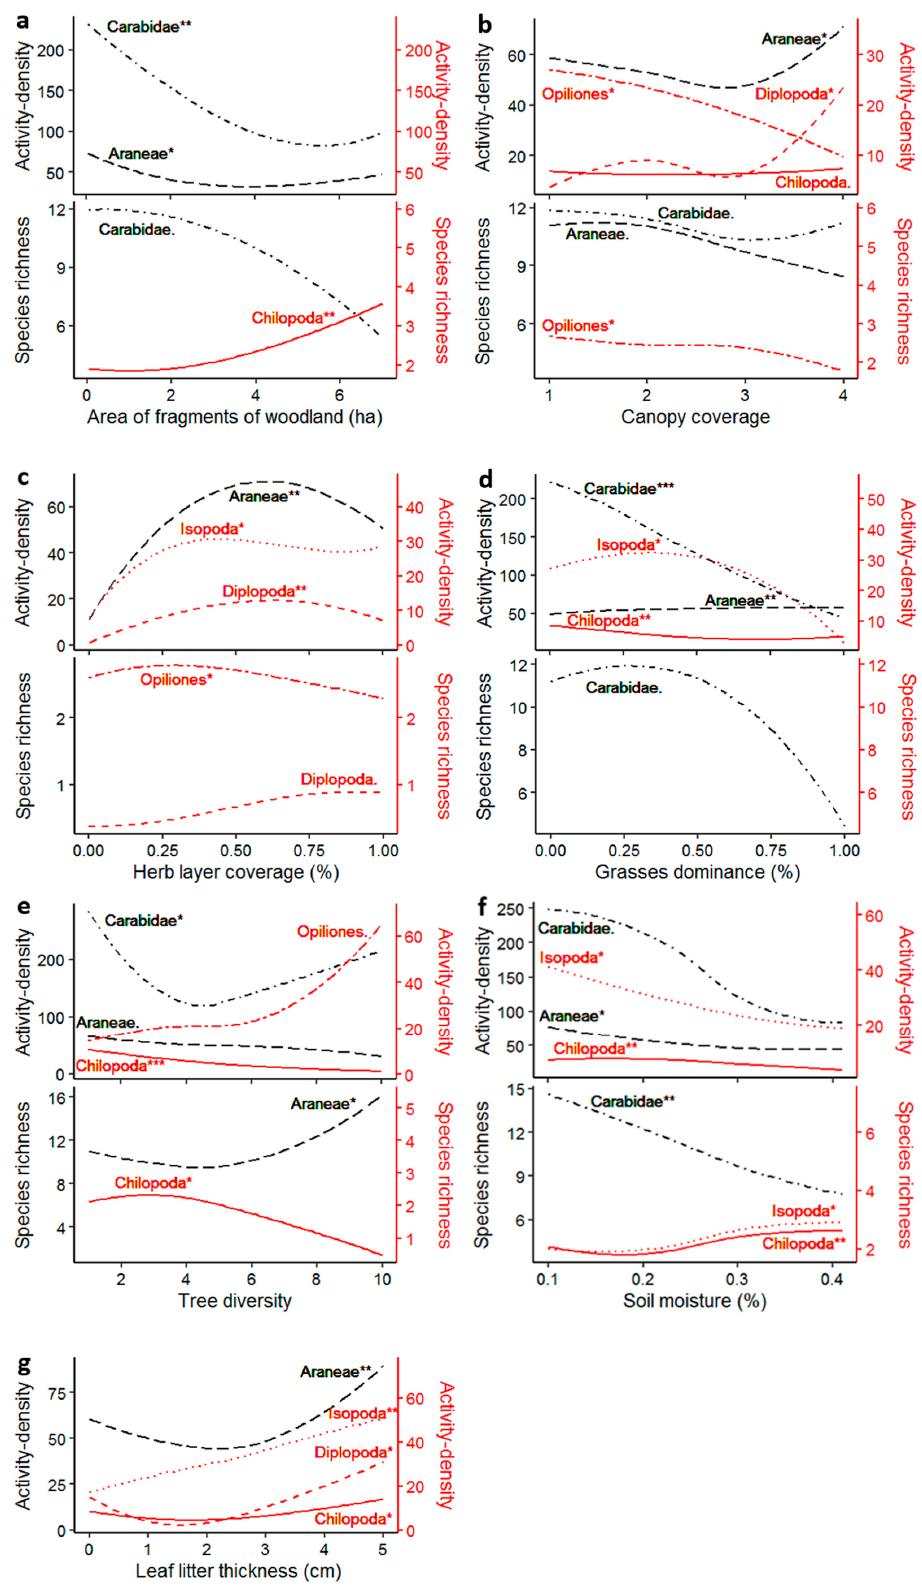
Figure 1. GAM plots visualizing significant relationships between measured environmental variables and individual taxonomic groups: ( a ) effect of the size of site on activity-density and species richness of taxa; ( b ) effect of density of tree canopy on activity-density and species richness of taxa; ( c )